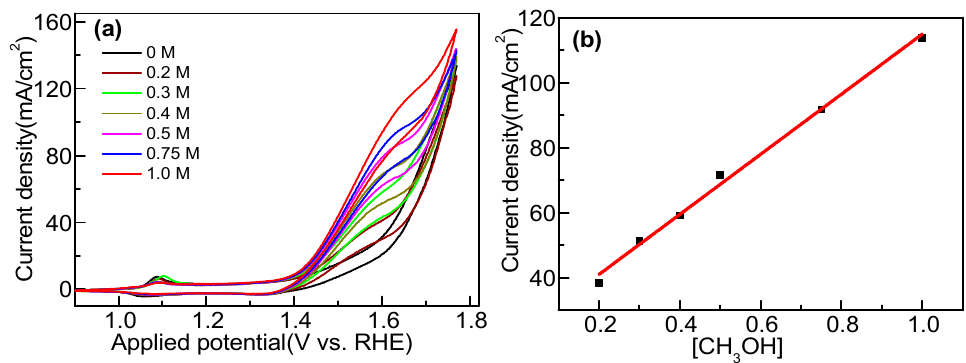
Figure 9. CVs of a Co 3 (PO 4 ) 2 nanosphere-modified electrode at 50 mV/s, ( a ) under various concentration of methanol solution, and ( b ) the plot of anodic methanol oxidation current density vs. methanol concentration at 1.65 V vs. RHE.